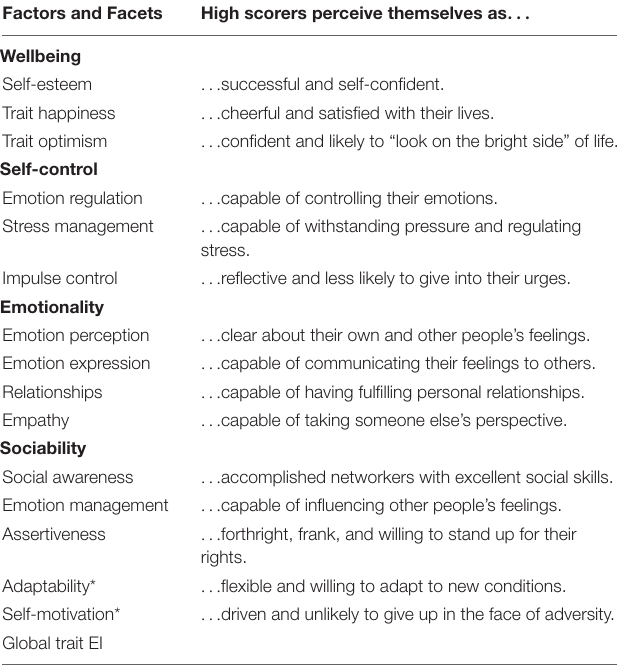
TABLE 1 | The sampling domain of trait EI in adults. Factors and Facets High scorers perceive themselves as ... Wellbeing